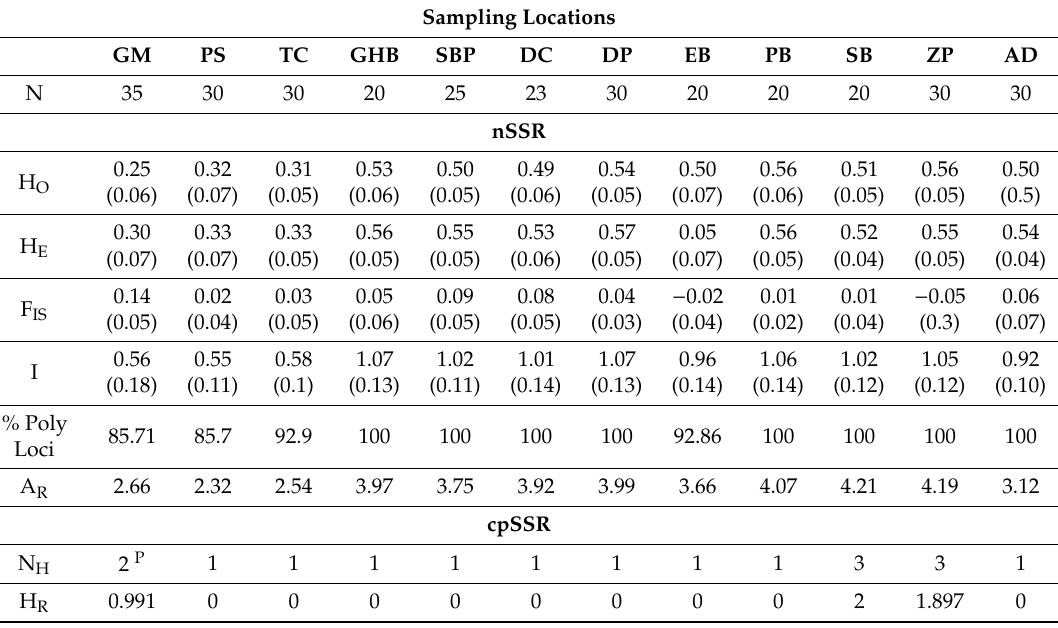
Table 1. Genetic diversity indices for G. paniculata from each sampling location across 14 nuclear microsatellite loci (nSSRs) and two chloroplast microsatellite loci (cpSSRs). Values in parentheses represent standard error. Sampling